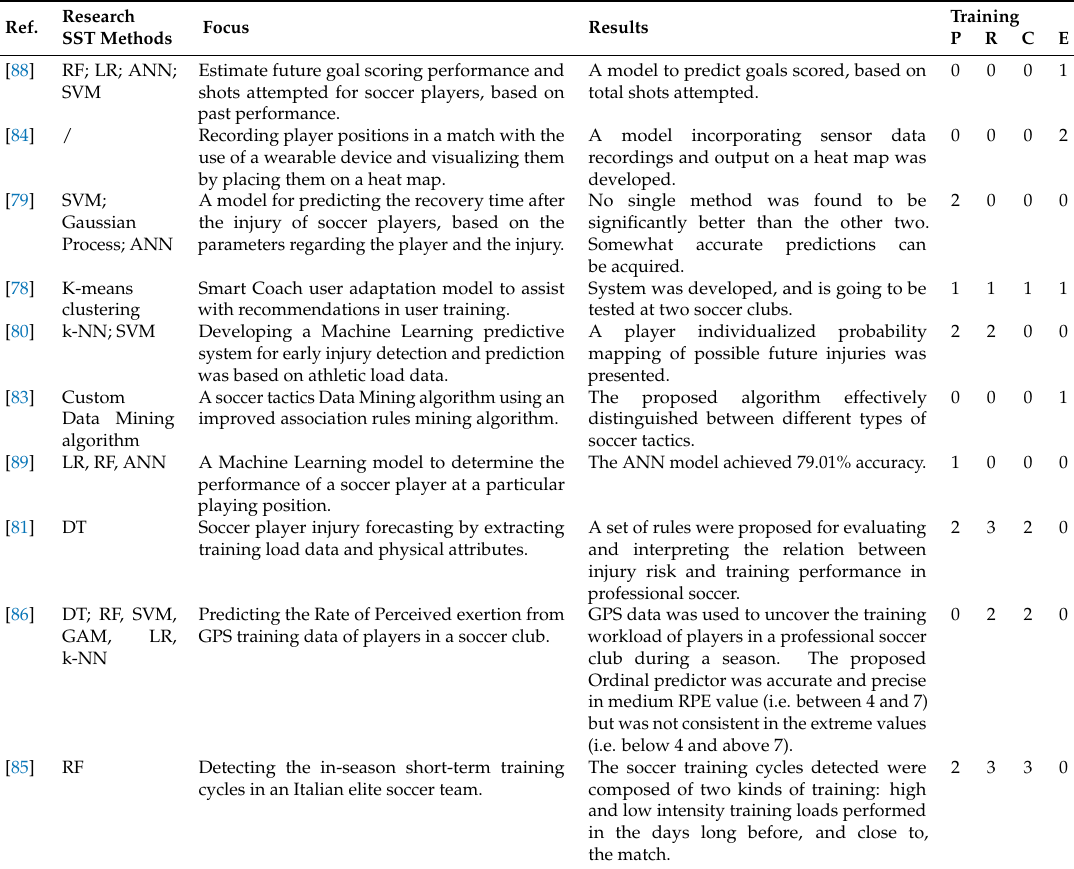
Table 11. Identified studies in the domain of